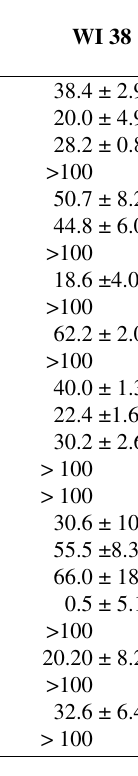
Table 1. Effect of newly synthesized compounds on the growth of three human tumor cell lines